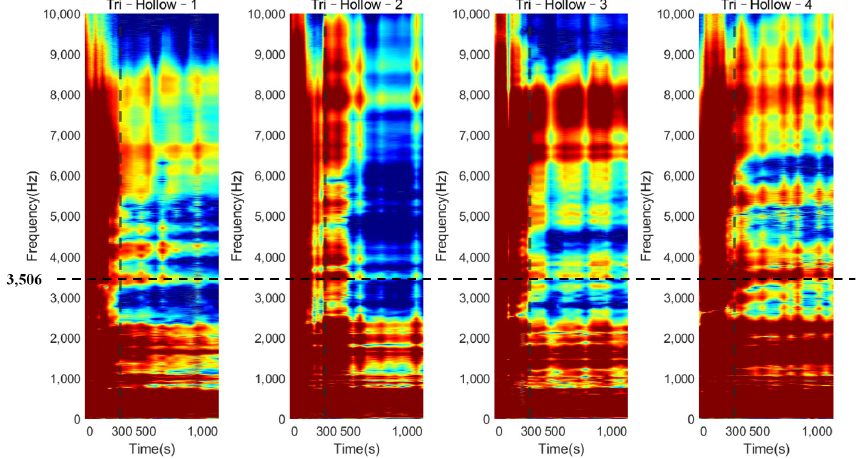
Figure 8. Plots of the normalized magnitude development as the function of cure time for triangular implants with a solid IM stem. Figure 9. Plots of the normalized magnitude development as the function of cure time for triangular implants with a hollow IM stem.